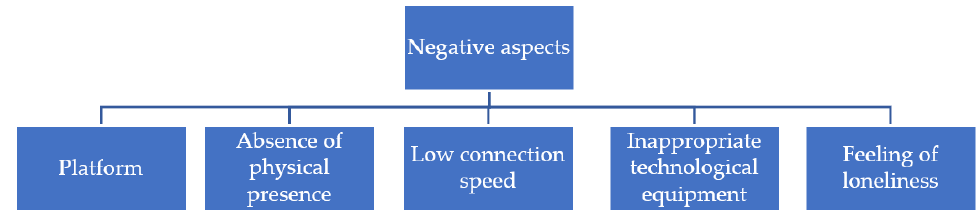
Figure 3. Reasons against online education.